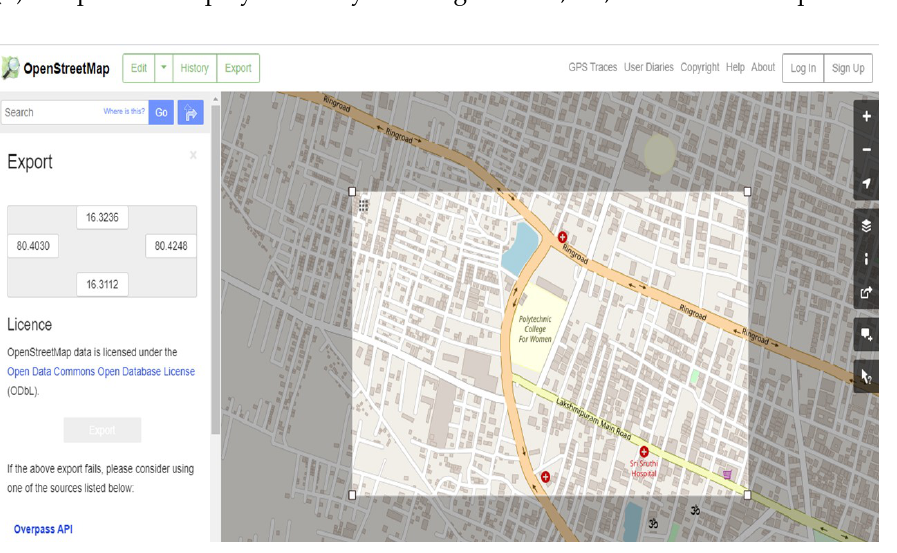
Figure 9. Open street map view for the sample execution.